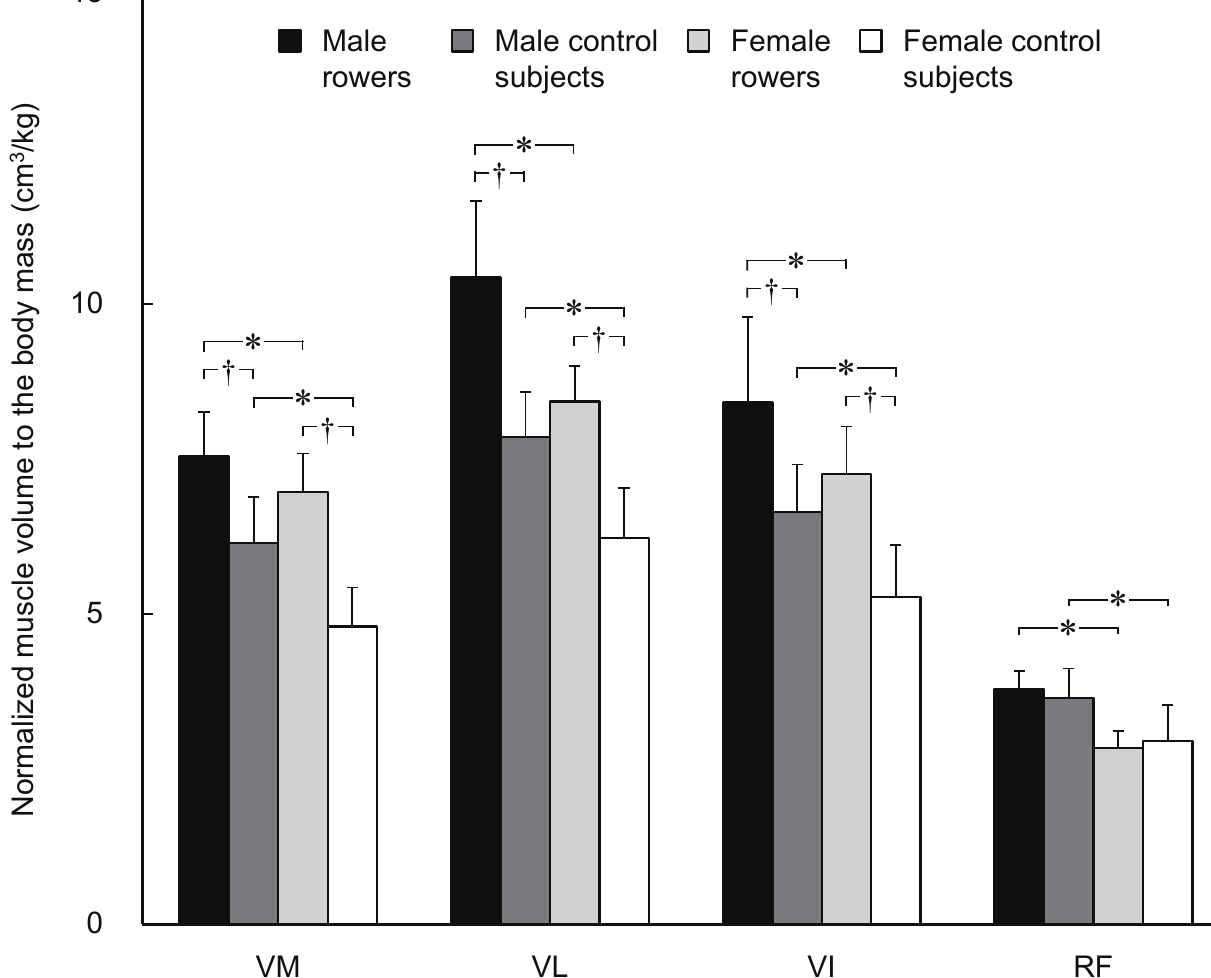
Fig 2. Muscle volume of each muscle normalized to body mass. * indicatesa significantdifference betweenmale and female rowers or betweenmale and female control subjects. † indicatesa significantdifference betweenrowers and control subjects within each sex. VM, vastus medialis;VL, vastus lateralis; VI, vastus intermedius; RF, rectus